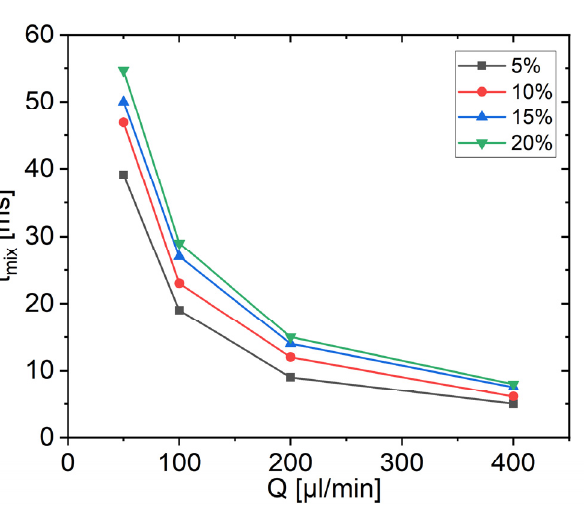
Figure 9. t mix obtained for the digital CLM with three stretch-and-fold units in dependence on the Figure 9. t (cid:2923)(cid:2919)(cid:2934) obtained for the digital CLM with three stretch ‐ and ‐ fold units in dependence on the total flow rate Q for varied flow rate total flow rate Q for varied flow rate ratios.